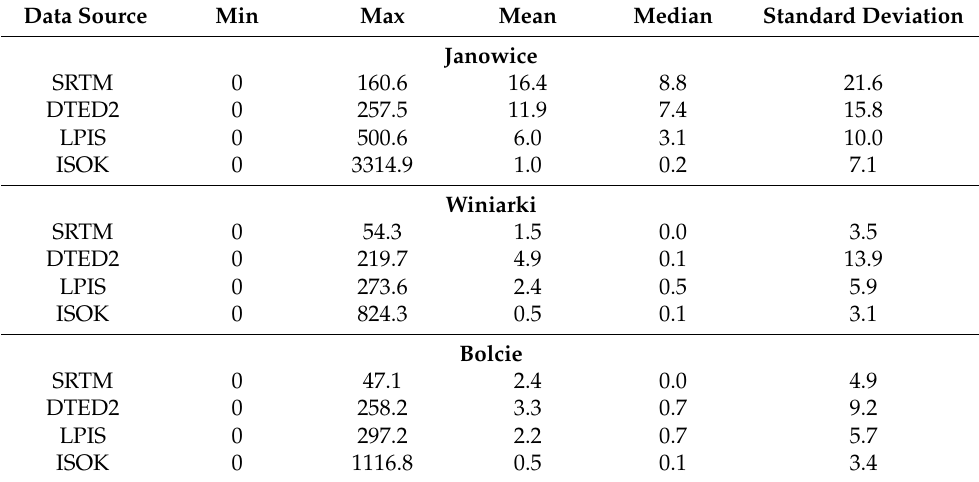
Table 10. Summary of the basic statistics for the total length/steepness (LS) factors values in the 3 research